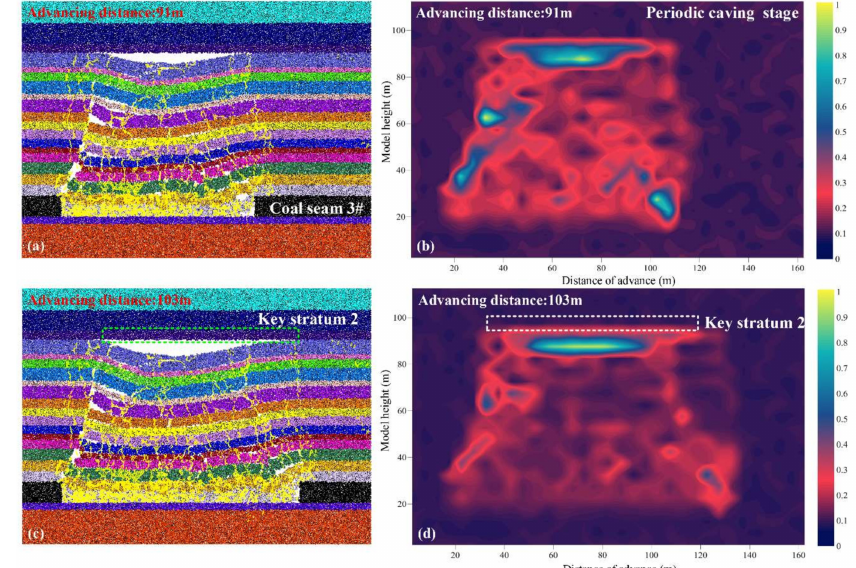
Figure 10. Dynamic evolution of cracks and porosity simulated with PFC 2D , showing changes in cracks in overburden strata as heading to 91 m ( a ) and 103 m ( c ) prior to the face; and changes in porosity to 91 m ( b ) and 103 m ( d ). The changes in porosity level are denoted by the change in color scale through the corresponding numerical